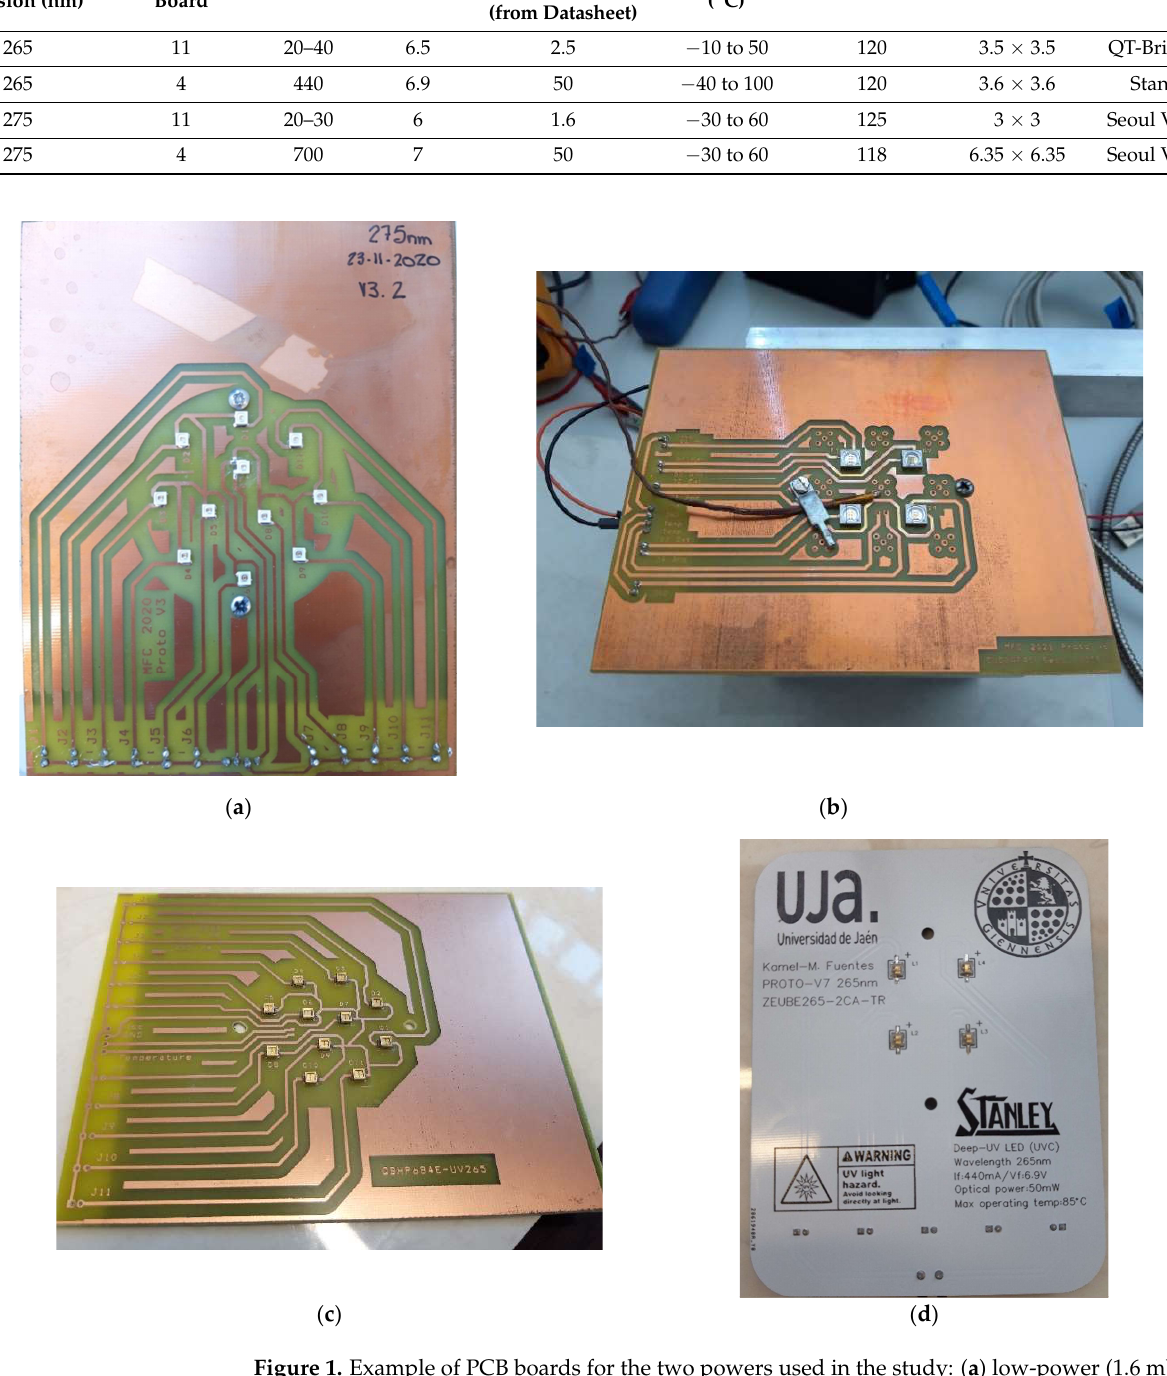
Figure 1. Example of PCB boards for the two powers used in the study: (a) low-power (1.6 mW) UV-